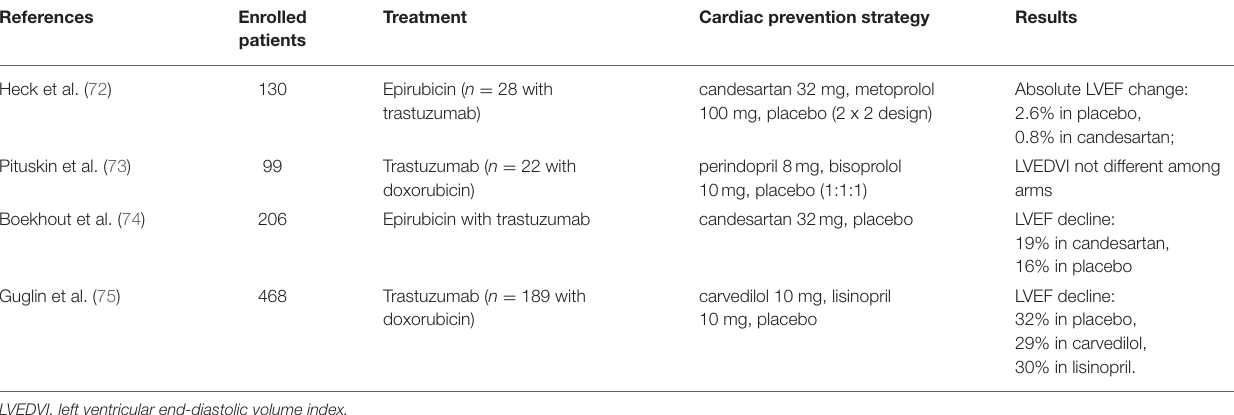
TABLE 2 | Primary cardiac prevention studies in patients with breast cancer receiving trastuzumab.